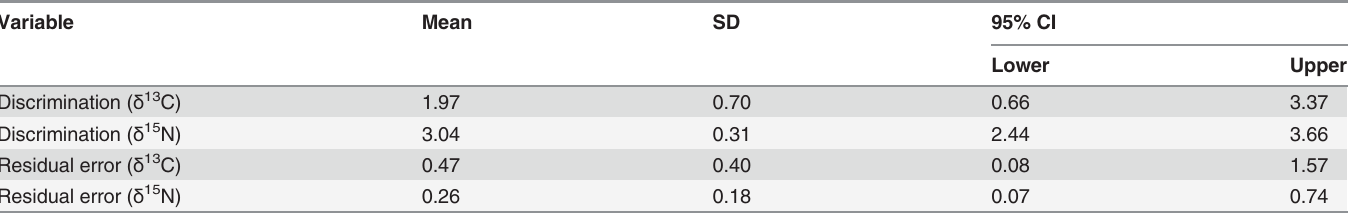
Table 2. Posterior density distributions of parameter estimates of a Bayesian stable isotope mixing model formulated to estimate discrimination factors of δ 13 C and δ 15 N between a gray wolves and their prey. Variable